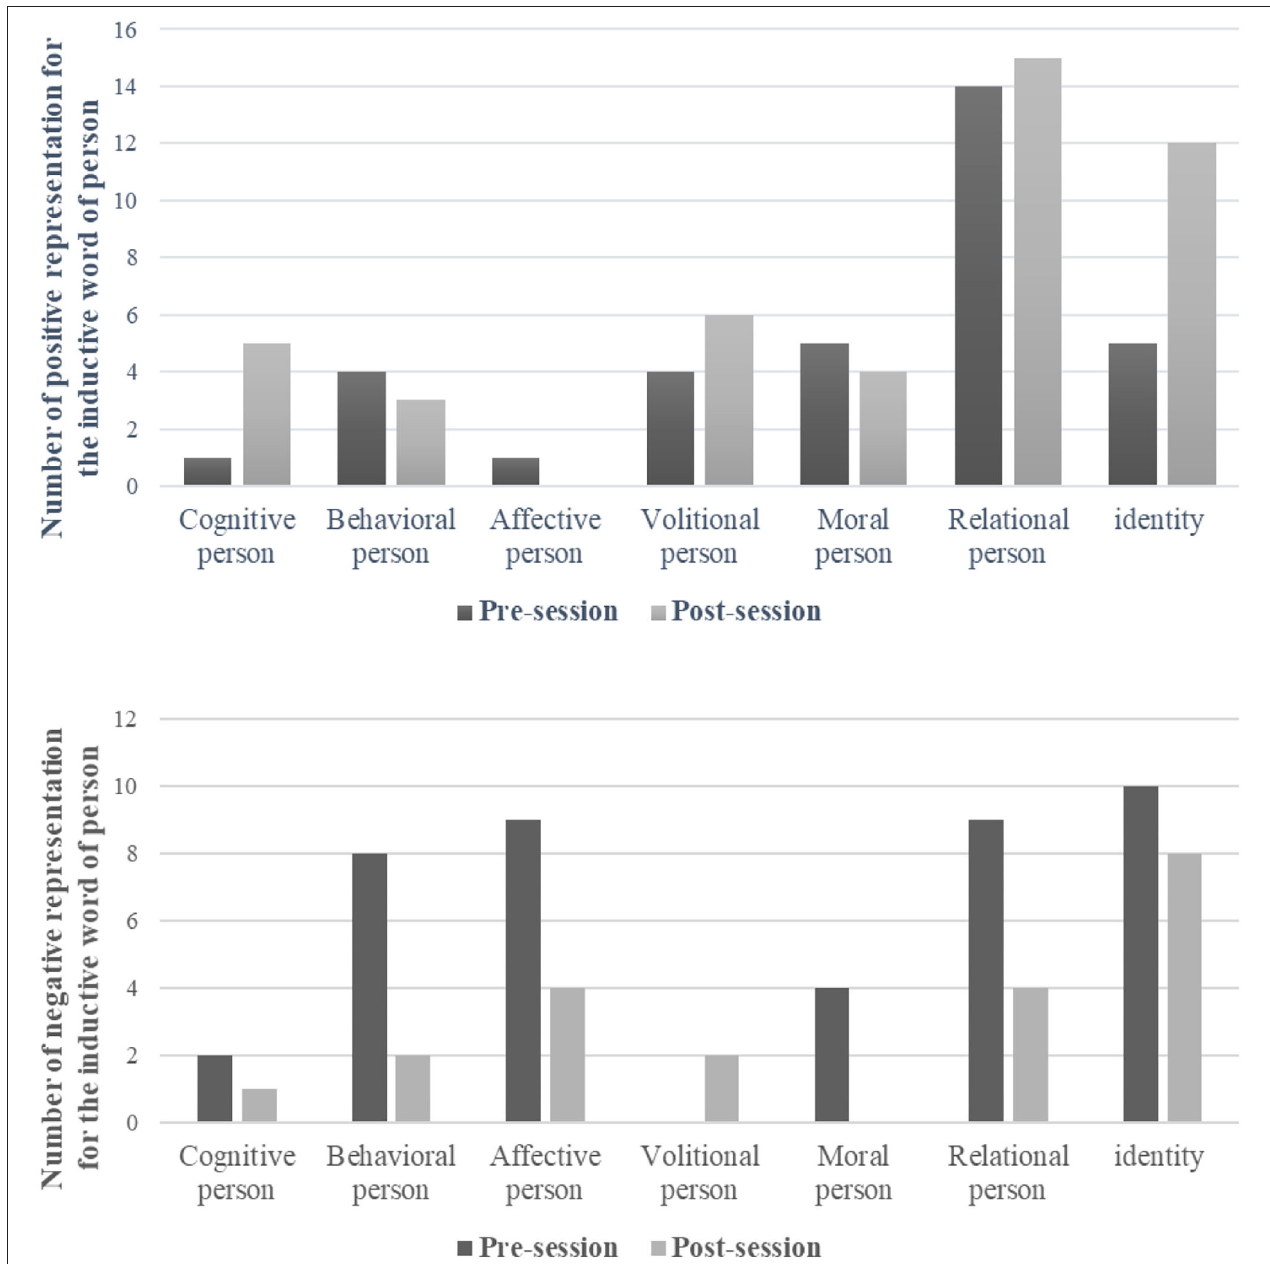
FIGURE 3 | Categories and numbers of positive (top) and negative (bottom) words used to refer to the person at pre-session and post-session.